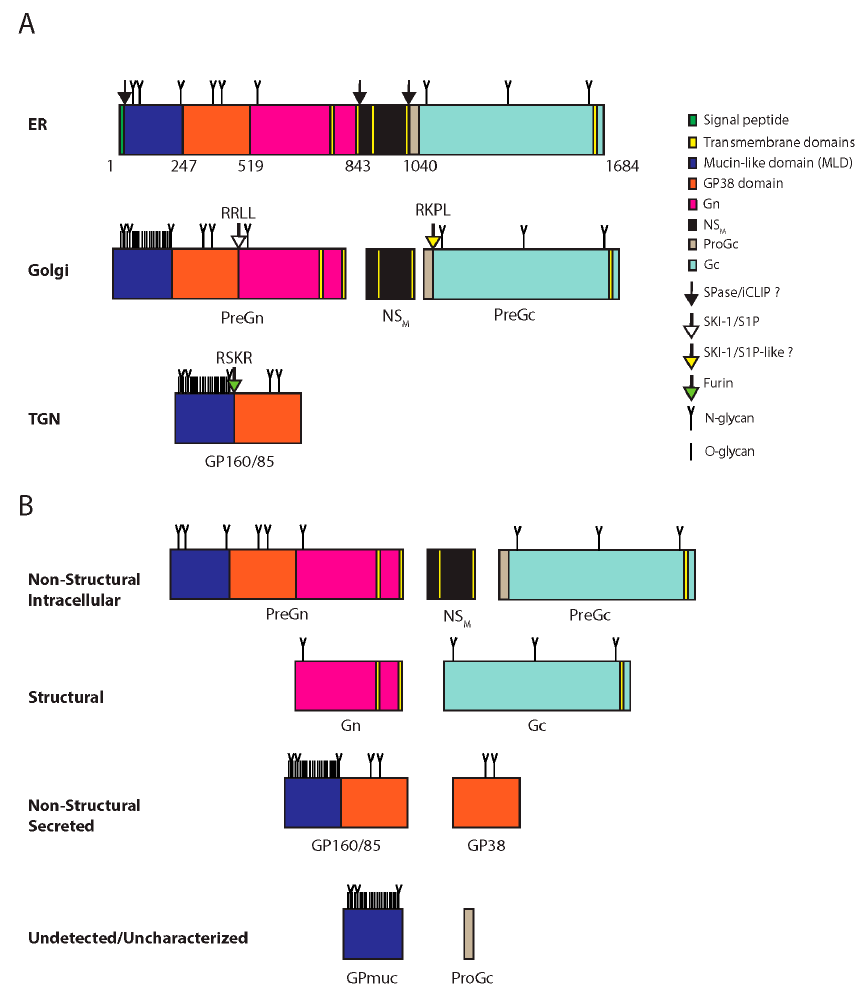
Figure 3. CCHFV glycoprotein processing and products. ( A ) CCHFV glycoprotein processing. The